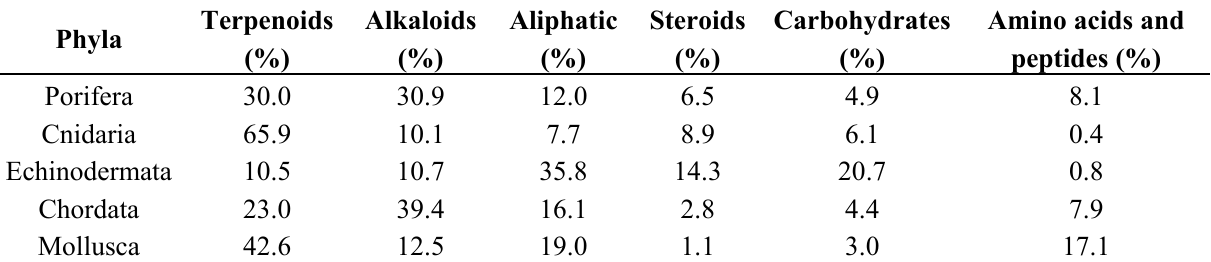
Table 1. Percentage (%) of new marine natural products from invertebrate sources considering the different chemical groups and corresponding phyla.